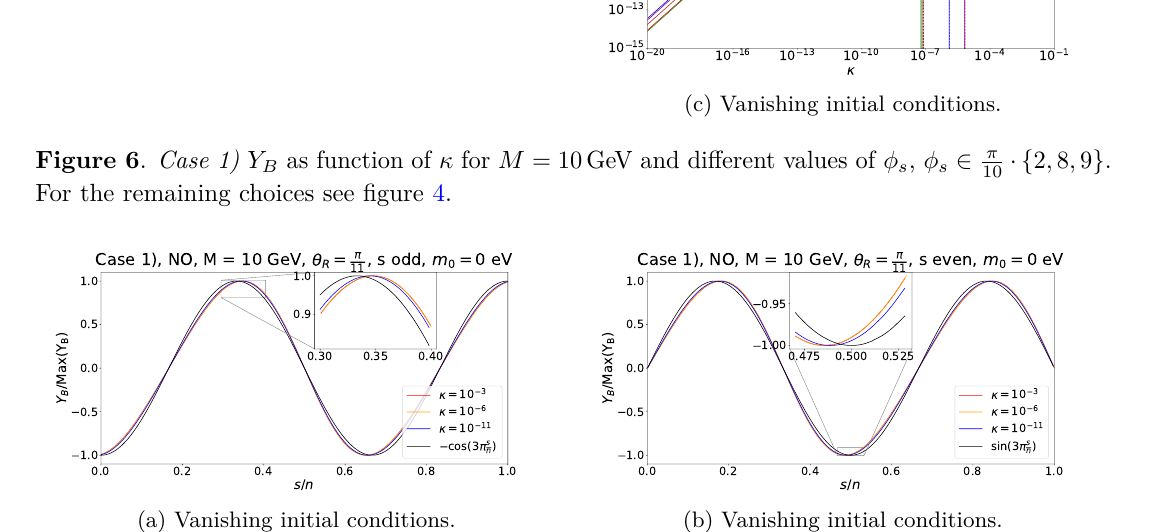
Figure 7 . Case 1) Y B as function of s even (right plot) values of s , respectively. The Majorana mass M is chosen as M = 10 GeV and three different values of κ , κ ∈ { 10 − 3 , 10 − 6 , 10 − 11 } , are used, see the red, orange and blue curve, respectively. Additionally, we display the dependence on φ combinations, compare eqs. (6.17) and (6.18), in black. The angle θ neutrino masses are assumed to have strong